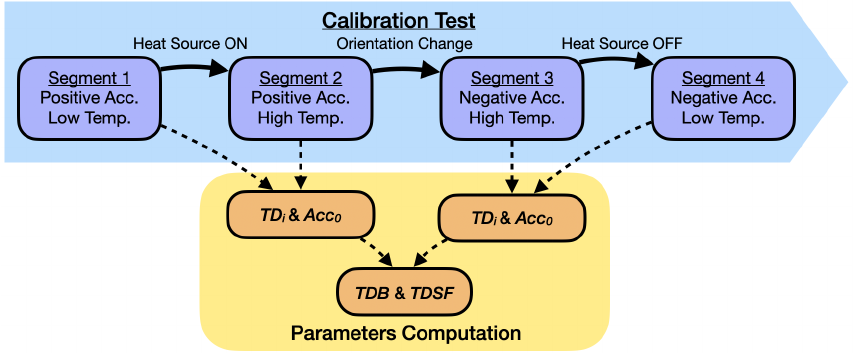
Figure 6. Hardware used during the tests. ( a ) Calibration structure (front), thermal chamber (left), and logging pc (right). ( b ) DUT with the cover ready to be tested.